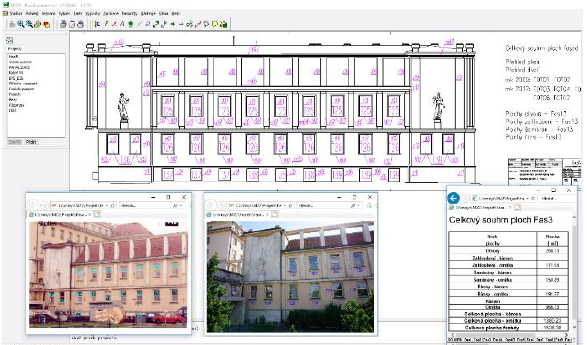
Figure 5. Facade passportization in MISYS SPRÁVA BUDOV.